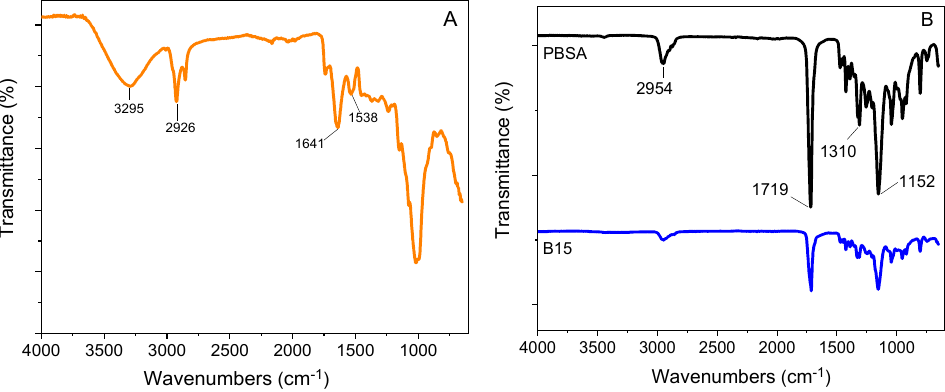
Figure 8. FTIR spectra of ( A ) bran, ( B ) neat PBSA, and the composite with 15 wt.% bran.